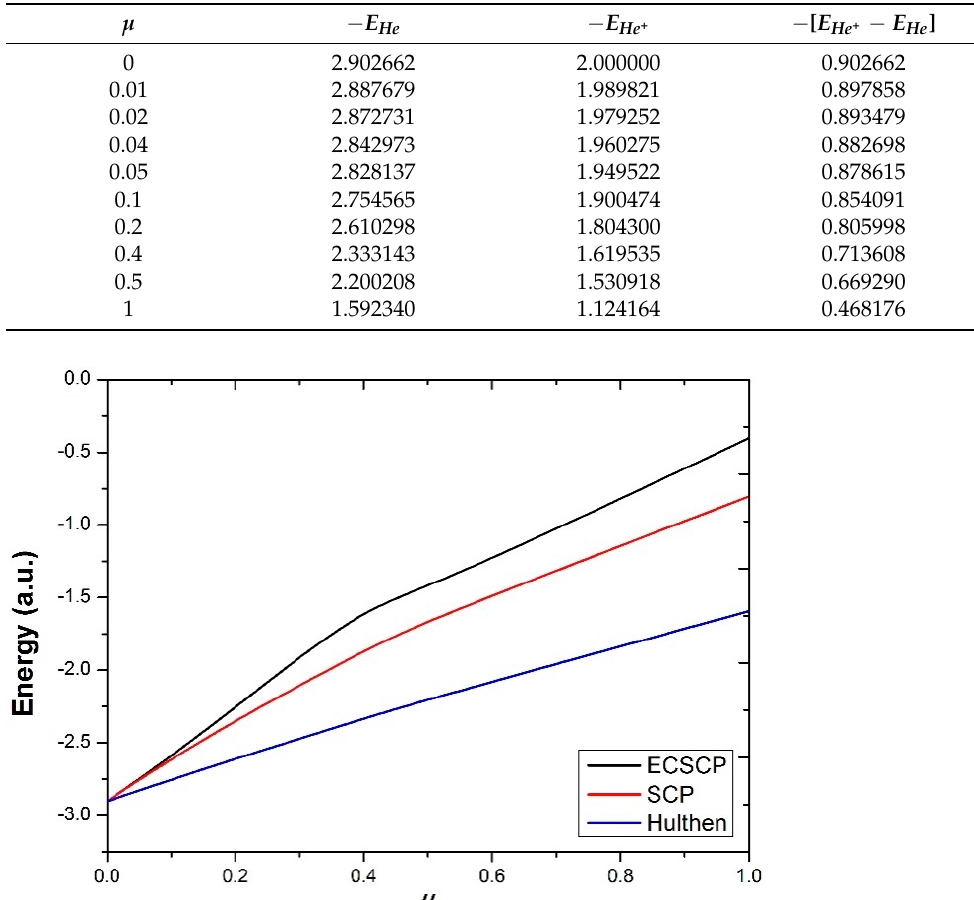
Table 3. Ground state energies of the helium atom under Hulth é n potential in dense quantum plasma. The He + threshold energies and ionization potential [ E He + − E He ] of He are also given.